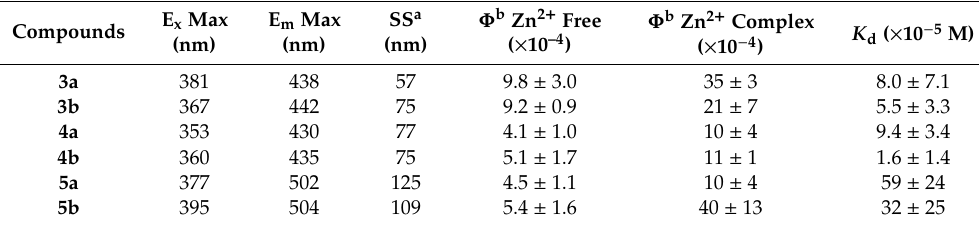
Table 1. Fluorescence data for compounds 3a,b , 4a,b , and 5a,b